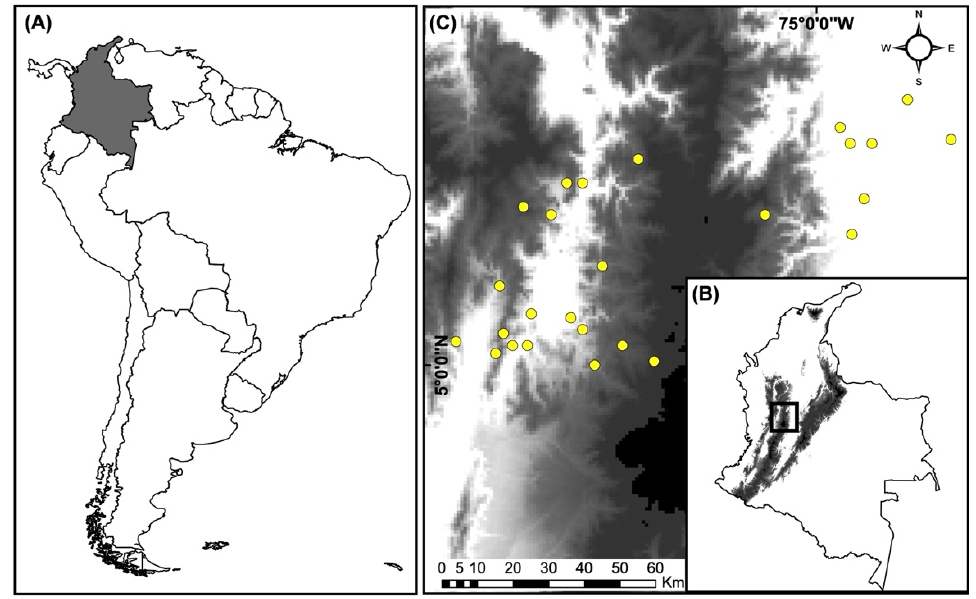
Figure 1. Location of the 26 landscapes included in the analyses: ( A ) location of Colombia in South America; ( B ) location of the study area in Colombia; and ( C ) location of the 26 landscapes in the Colombian Andes.